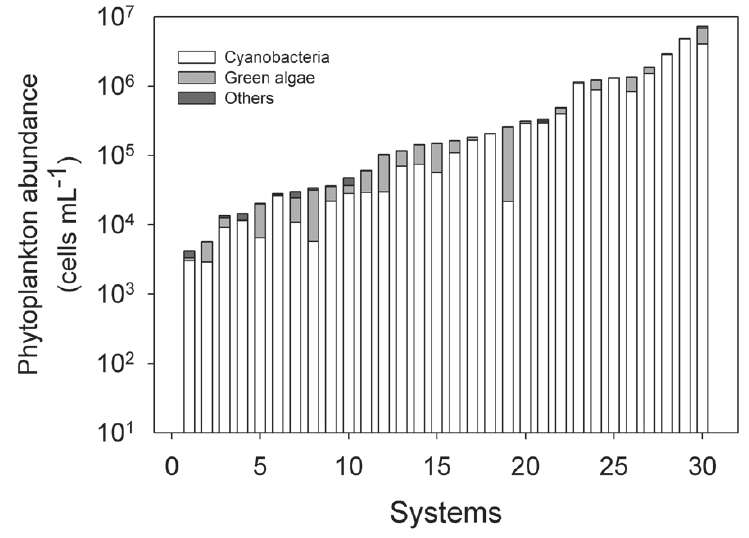
Figure 2 - Phytoplankton abundance (log scale) sorted by major taxonomic group, in 30 fishponds in southeastern